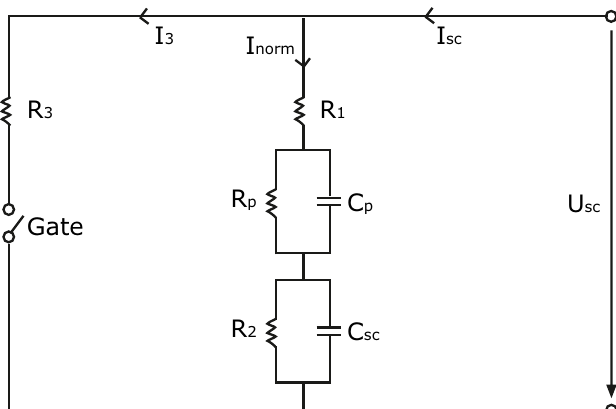
Figure 7. Circuit diagram of the supercapacitor